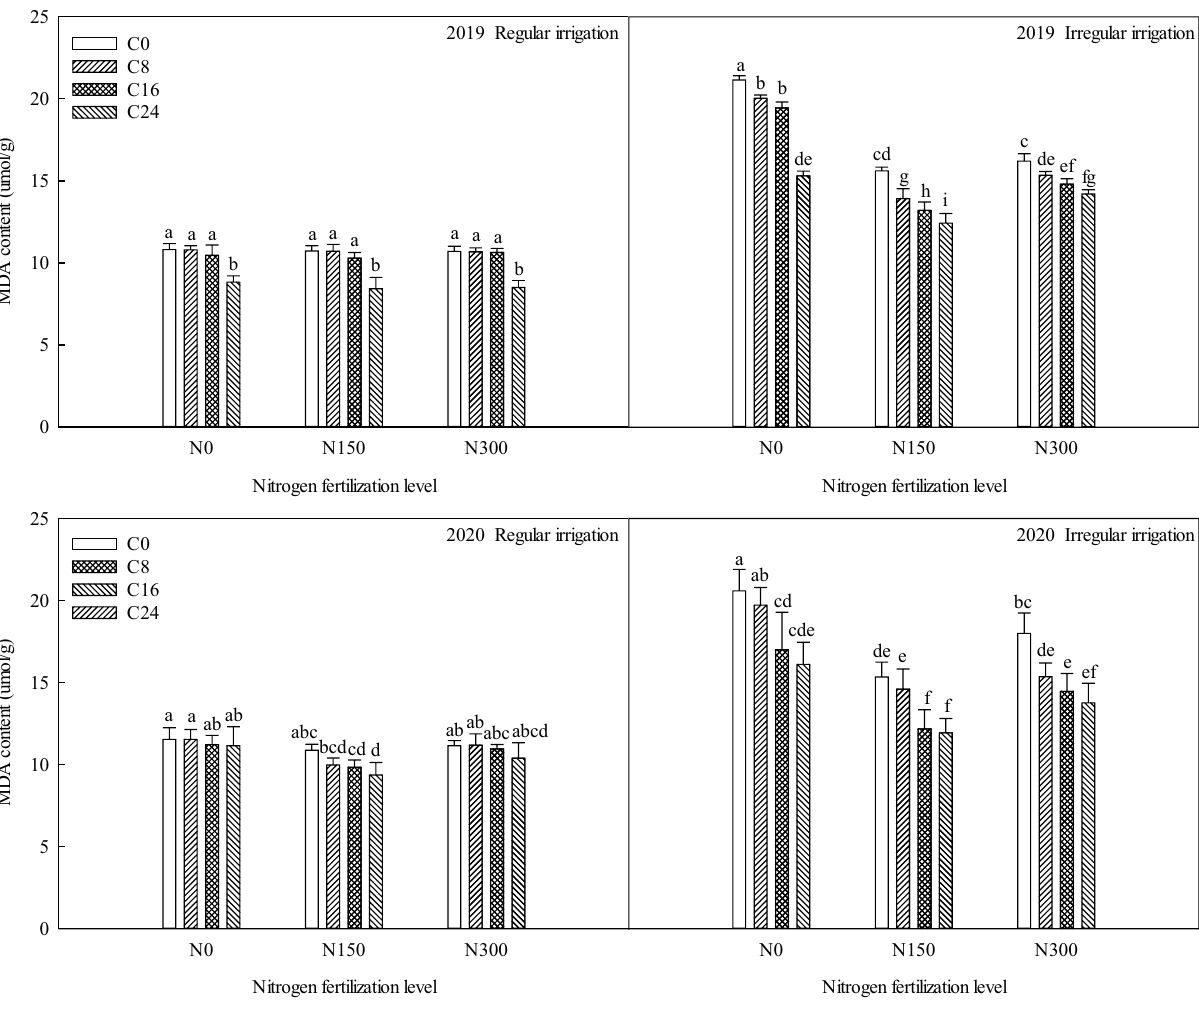
Figure 1. Effects of bio-char and nitrogen fertilizer on MDA content of maize under different irrigation